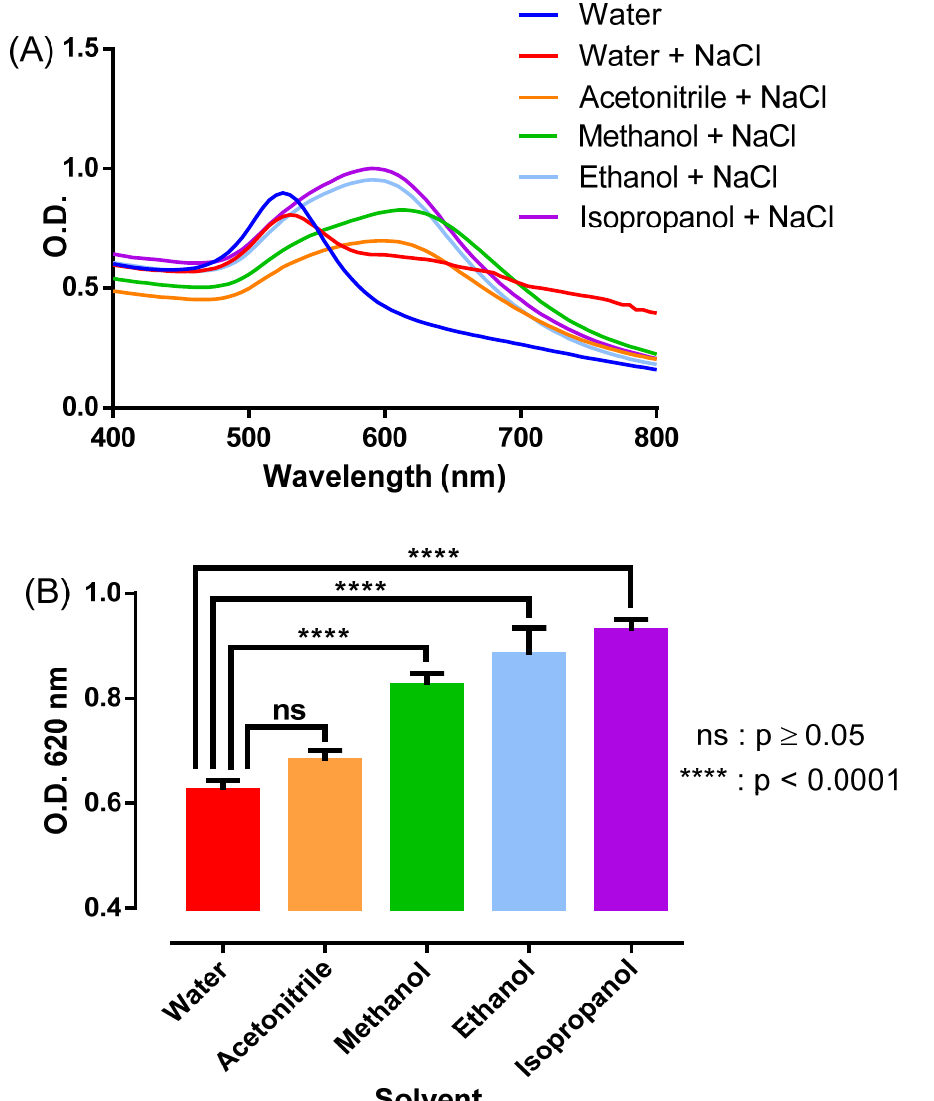
Figure 4. Comparative analysis of salt-induced NAS aggregation in water, acetonitrile, methanol,